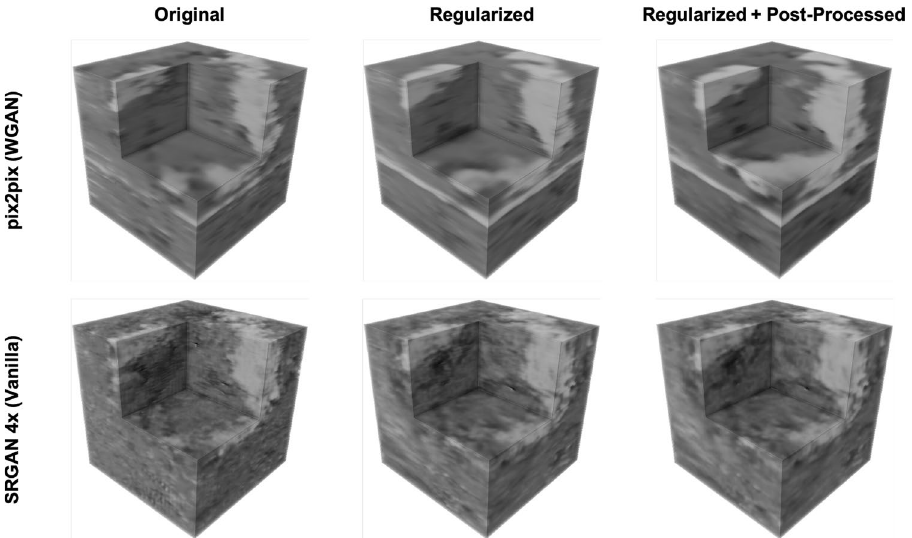
3 Figure 4. Test set volume renderings. Image volume is a 128 voxel volume from a part of the imaged TXM volume held out as a test set. Volumes are evaluated for the pix2pix (WGAN) and SRGAN 4x (Vanilla) models for the original model, model trained with z -regularization, and regularized model with median filter post- processing using a 3 × 1 × 1 structuring element. The x – z and y – z cross sections show improved z -direction continuity for the regularized and post-processed images. Software: Powerpoint www. micro soft. com, MATLAB www. mathw orks.